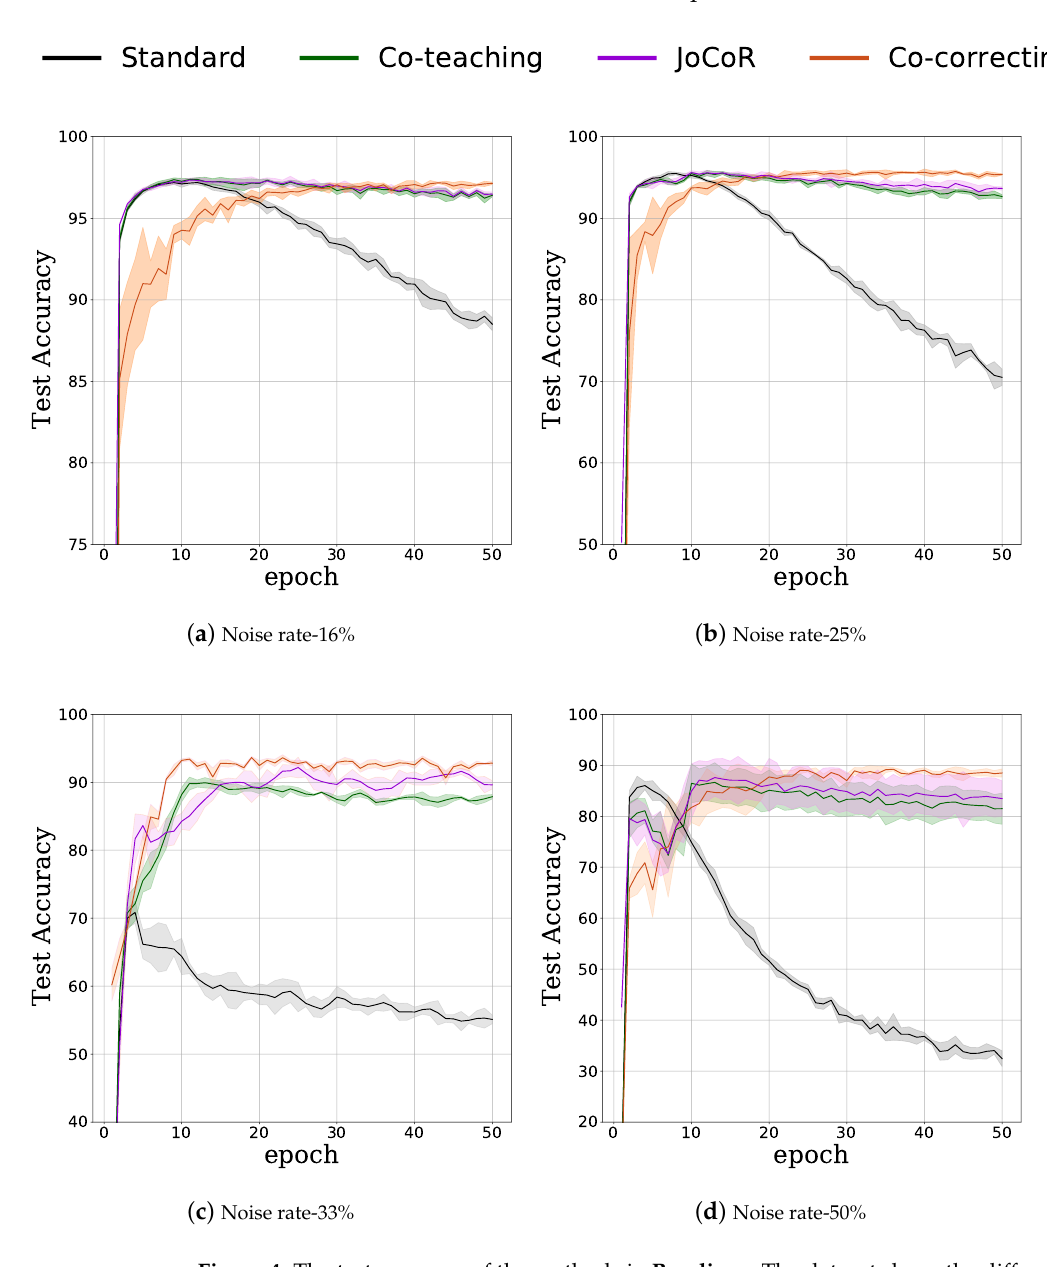
Figure 4. The test accuracy of the methods in Baselines . The datasets have the different label noise rate. The label noise rate is: ( a ) noise rate 16%, ( b ) noise rate 25%, ( c ) noise rate 33%, and ( d ) noise rate 50%. Each experiment is repeated five times. The error bar for STD in each figure has been highlighted as a